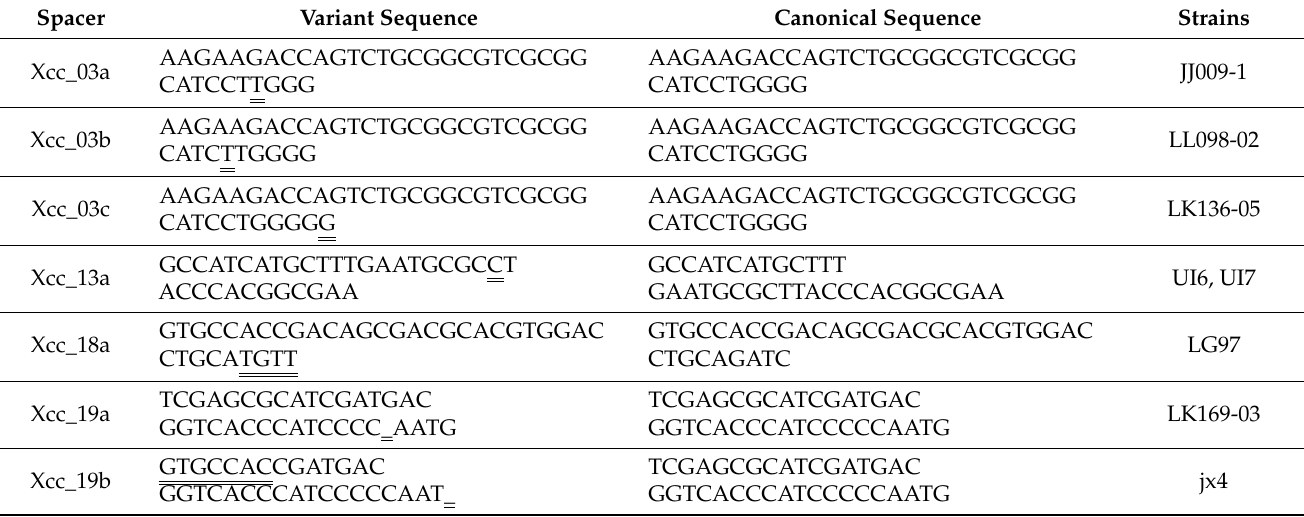
Table 3. Variant spacer sequences in X. citri pv. citri